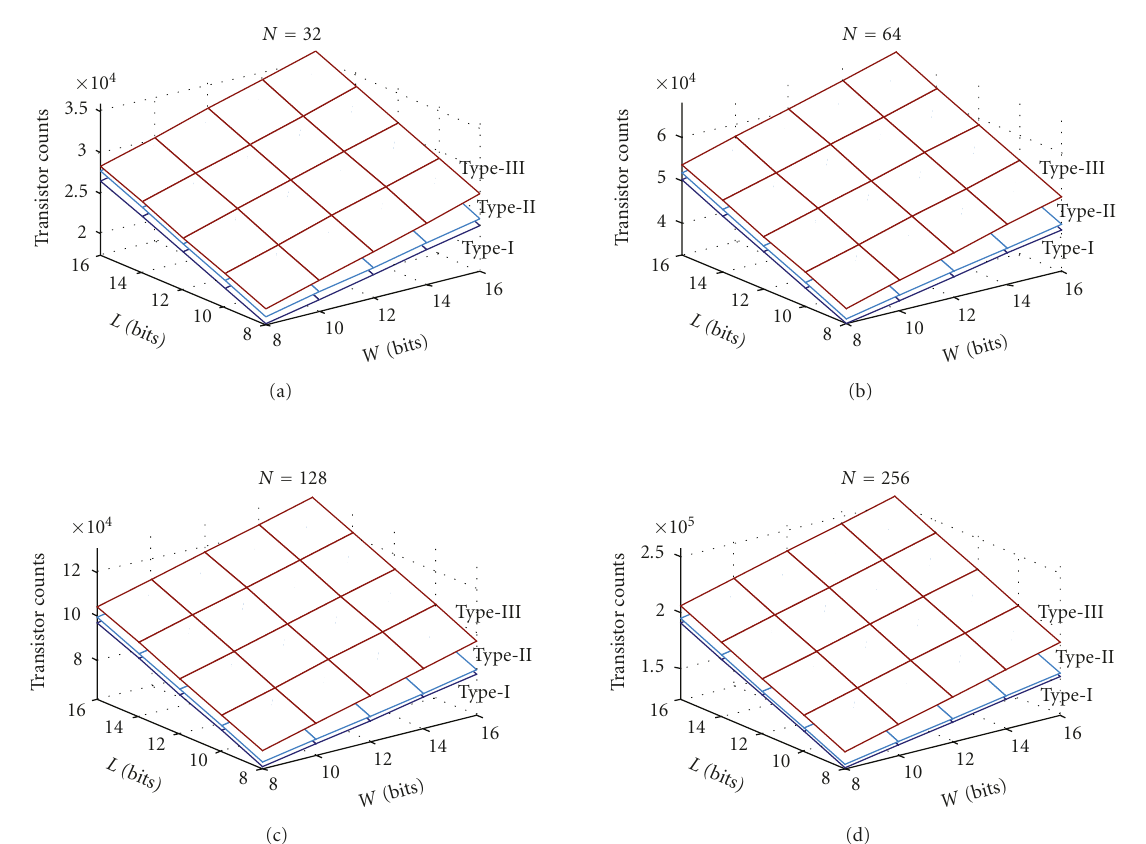
Figure 8: Transistor counts of three types of the FIR architectures using input-data and tap